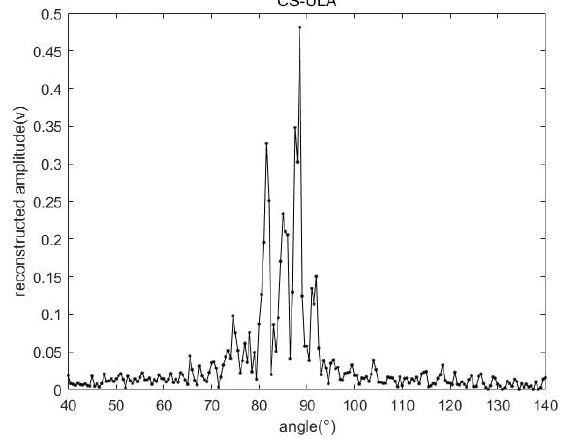
Figure 9. Reconstruction effect based on spatial sparse reconstruction method. We also compare the target detection and reconstruction effects of several different measurement matrices under different compression ratios, as shown in Figures 10 and 11, the reconstructed target with different measurement matrices in 70% and 44% compres- sion ratios respectively. We normalized the final reconstruction amplitude to make the comparison between each matrix more obvious and compared the reconstruction effect before and after compression.